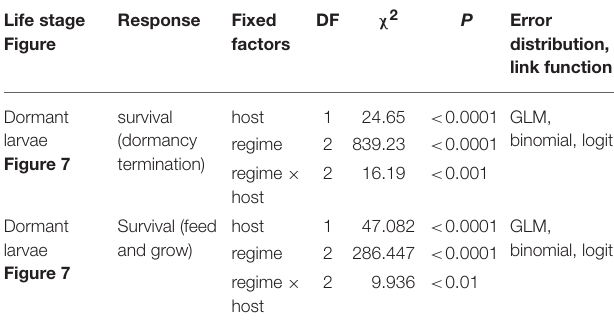
TABLE 2 | GLM summaries for effects of heatwave exposure during winter on survival of pre-overwintering larvae.